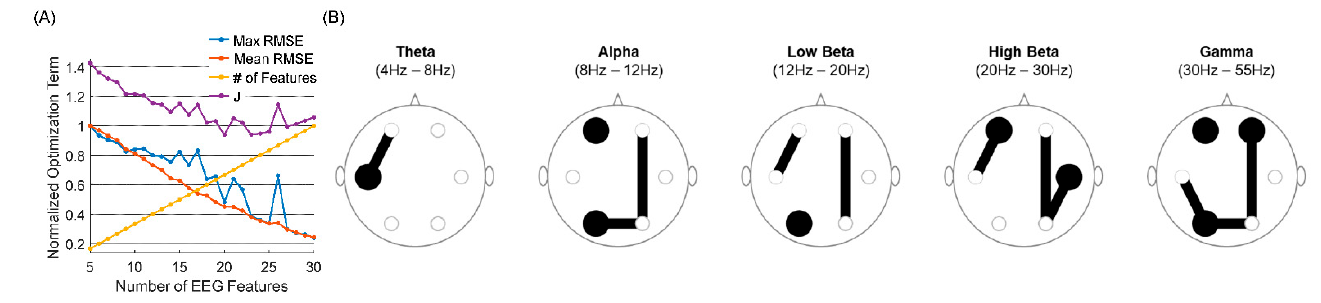
Figure 4. EEG feature selection results. ( A ) For each number of EEG features, a comparison of the normalized mean and maximum RMSE values, and optimization function ( J ). The features were computed on the epoch window that was 1400 ms before the distractor. ( B ) Features (connections) selected by our algorithm as important for predicting RT.